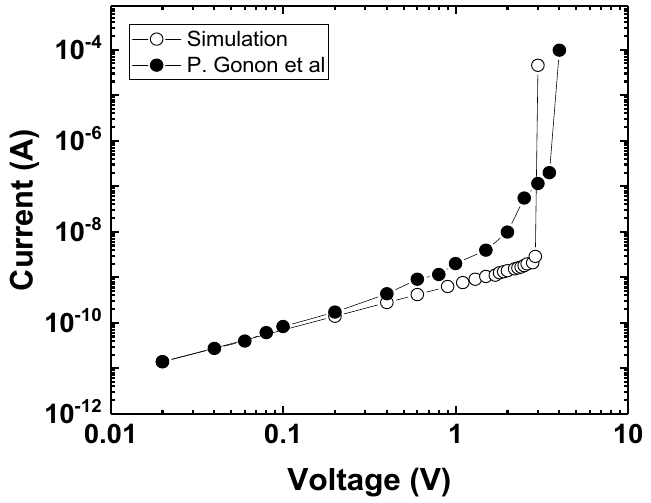
Figure 3. Comparison of simulated and experimental current–voltage curves for a 10-nm-thick HfO 2 film. This simulation was carried out in 3D, and the experimental data were obtained from Gonon et al 41